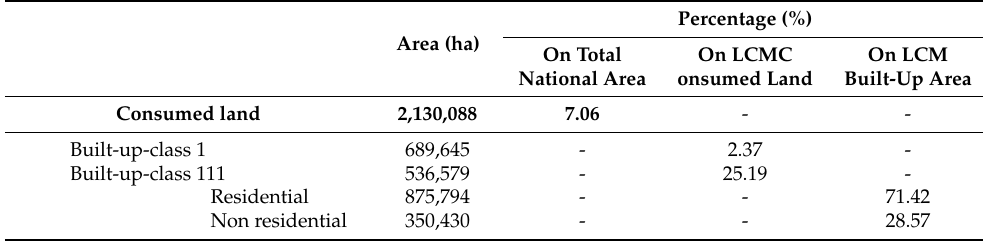
Table 3. Extension of total consumed land and of classes 1 and 111 of the LCM and extension of residential and non-residential areas within classes 1 and 111 of the LCM.